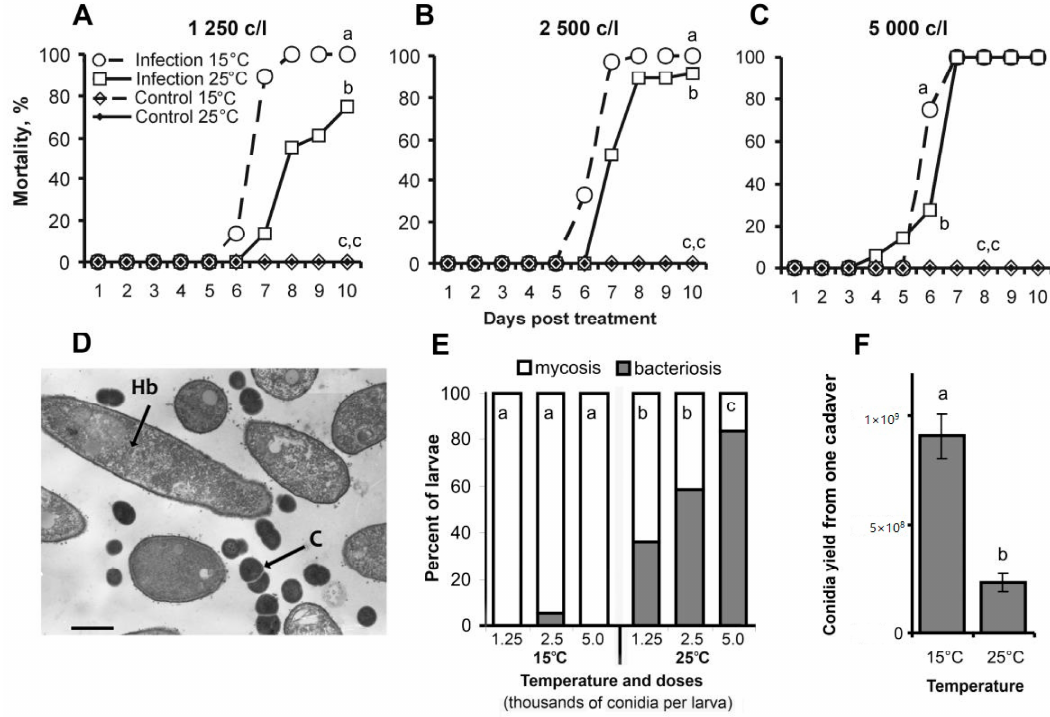
Figure 1. Mortality dynamics and outcome of infection in wax moth larvae after injection with C. militaris conidia and subsequent incubation at 15 ◦ C and 25 ◦ C. ( A – C )—mortality dynamics after injection of larvae with 1250, 2500 and 5000 conidia per larva (c / L). Di ff erent letters indicate significant di ff erences determined by log rank test ( χ 2 > 9.6, df = 1, p < 0.002). ( D )— C. militaris hyphal bodies (Hb) and cocci (C) in wax moth hemolymph at 5 days after injection with the fungus. Scale bar, 1 µ m. ( E )—portion of mummified and decomposed larvae during the development of mycoses at di ff erent temperatures. Di ff erent letters indicate significant di ff erences ( χ 2 > 8.7, df = 1, p < 0.003). ( F )— C. militaris conidial yield on mummified cadavers at 15 ◦ C and 25 ◦ C. Di ff erent letters indicate significant di ff erences determined by t -tests ( t = 6.1, df = 8, p <